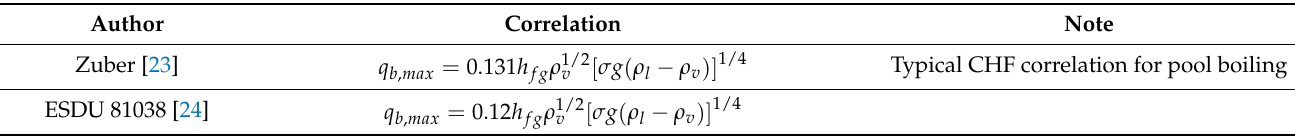
Table 2. Boiling limit correlations for a gravity-aided